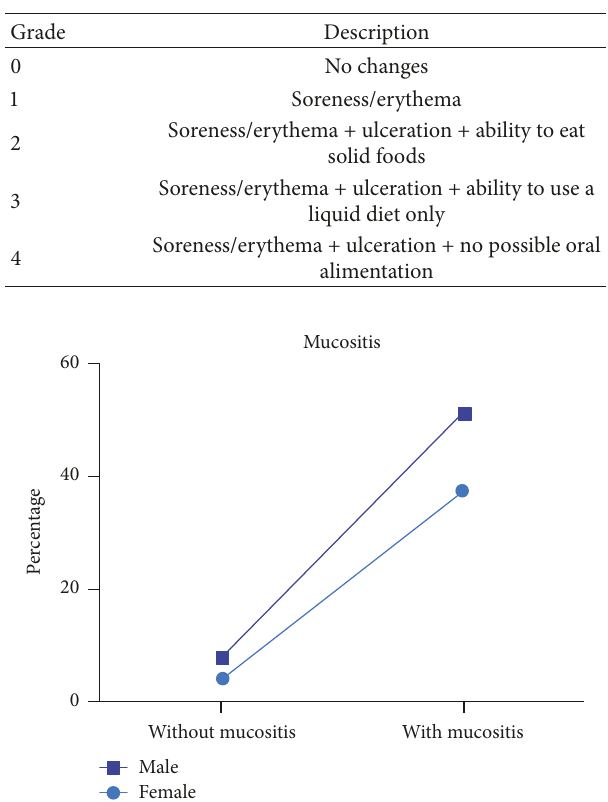
Table 1: The World Health Organization grades of oral mucositis [14].